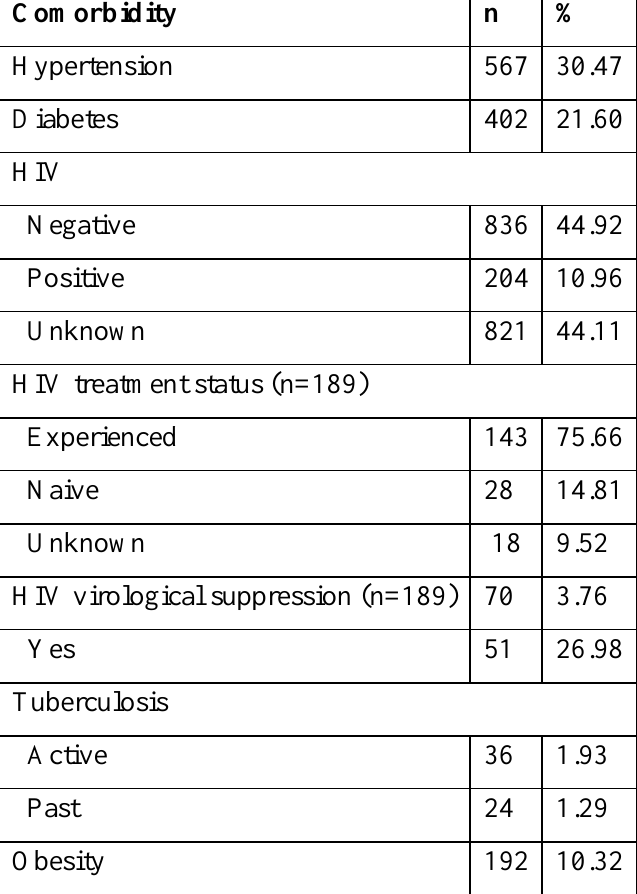
Table 3. Comorbidities reported in COVID-19 cases admitted at Charlotte Maxeke Hospital, 5 March 2020